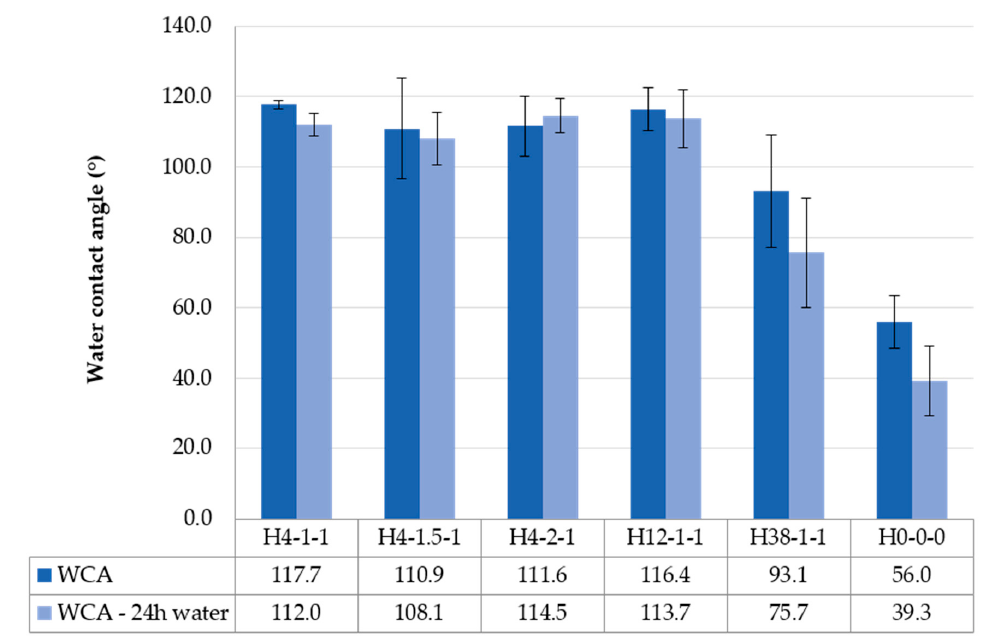
Figure 5. Water contact angle measurements on hemp shiv before (dark shade) and after immersion in a water bath for 24 h (lighter shade). The error bars represent the standard deviation of measurements for each type of sample (several hemp shiv were analysed).